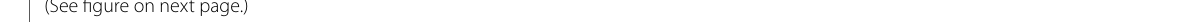
4 per group. B Inhibition of FDPS decreased = 7–8 = 3 per = 20 μm. = 7–9 per group. E Immunoblot analysis for P62 in the = 3 per group. Data are =